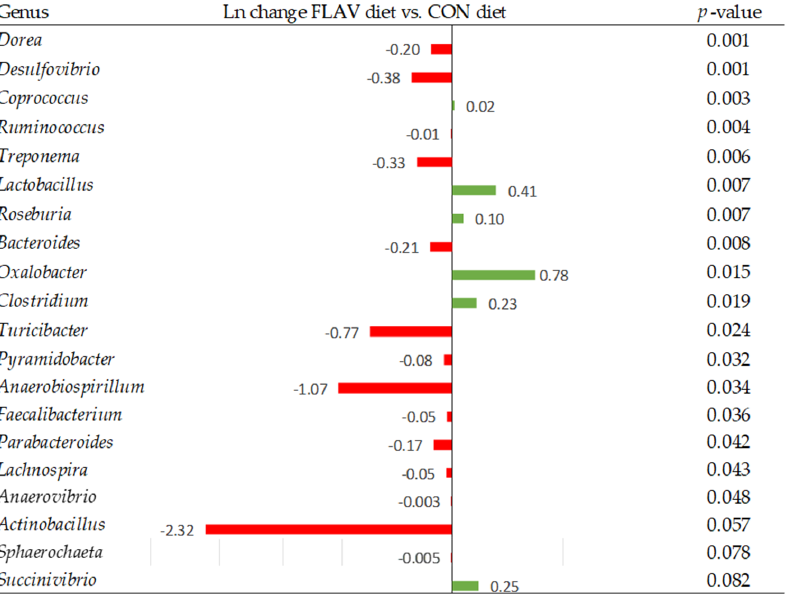
Figure 8. Differentially abundant taxa (Ln change) between a diet supplemented with antimicrobial compounds (ZnO) and a diet supplemented with flavonoid compounds (FLAV). Positive values (green color) and negative values (red color) indicate greater and lower abundance, respectively. Taxa are sorted by level of significance (from higher to lower). Only significant taxa are presented ( p- value < 0.10). Data are means of 6 replicate pens for the main effect of level (one pig per replicate pen was sampled). 3.5. Intestine Histomorphometry Measurements Ileum histomorphometry parameters are shown in Table 6. No effect of experimental diets on ileum histomorphometry parameters was observed except for a tendency on vil- lus height ( p = 0.094) and villus height to crypt depth V:C ratio ( p = 0.059). Pigs fed the ZnO diet tended to have longer ileum villi and a higher V:C ratio than those fed the CON diet.